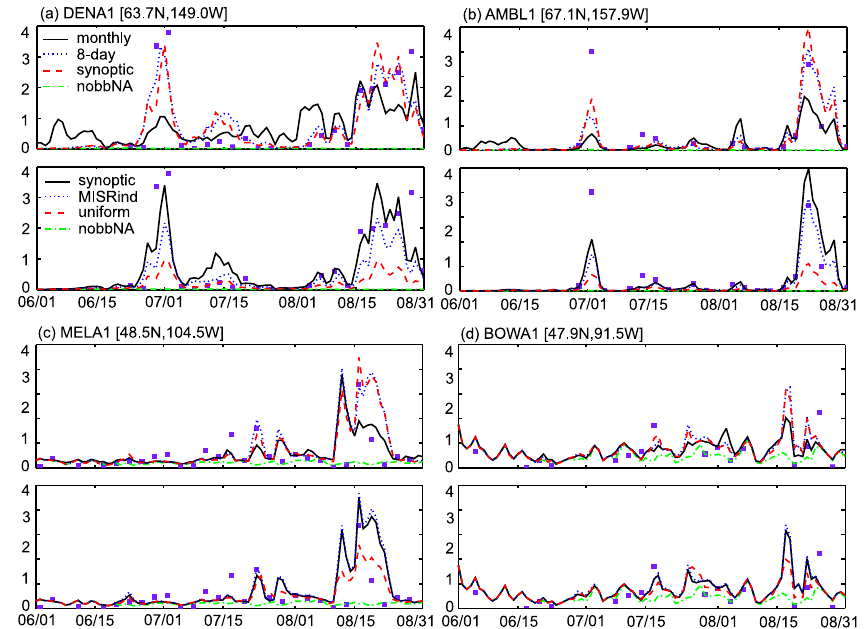
Fig. 12. Time series of surface BC concentrations ( µ g/m 3 ) from model simulations and IMPROVE observations (filled square boxes). IMPROVE measurements are 24h average values which were recorded each 3 days. Upper panel for each site shows the sensitivity to temporal constraints. Bottom panel for each site shows the sensitivity to injection height.